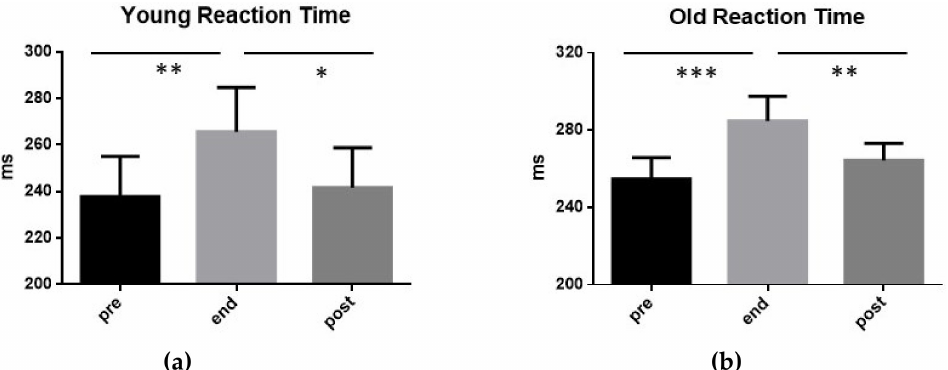
Figure 2. Values of RT exhibited by the 15 subjects of group YOUNG ( a ) and by the 15 subjects of group OLD ( b ) performing an exhaustive exercise. In both cases, RT mean value measured before the exercise (pre), at its conclusion (end), as well as 15 min after its end (post) are displayed. Symbols from ANOVA with Dunn’s multiple comparison test: * p < 0.05, ** p < 0.01, *** p <